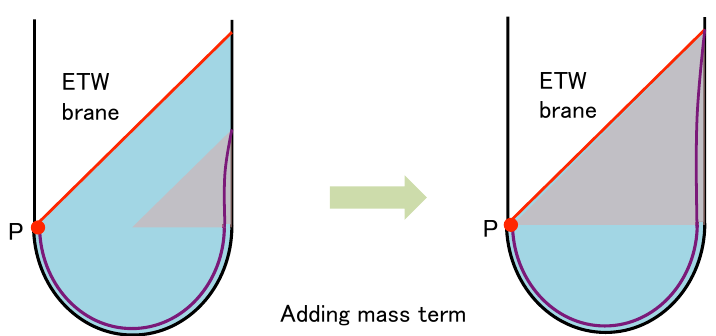
Figure 4 . The gravity interpretation of evolution in di(cid:11)erent Hamiltonian. The left (cid:12)gure is the case where we evolve the state by the SYK Hamiltonian. The motion of the UV cuto(cid:11) particle terminates at the (cid:12)nite Poincare time and correspondingly only the inside of the Rindler patch is visible from the boundary. The right (cid:12)gure is the case where we evolve the state by the mass deformed Hamiltonian. The motion of the UV cuto(cid:11) particle extends to whole the Poincare time and whole the spacetime within the EOW brane is